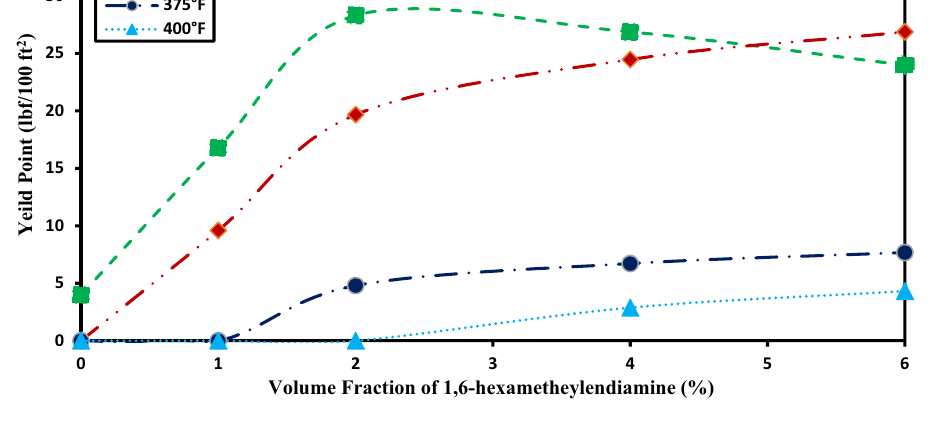
Fig. 11 Effect of the combina- tion of 1,6-hexamethylenedi- amine and PAC on initial gel